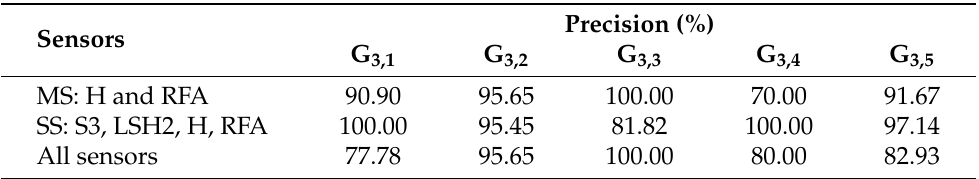
Table 11. Precision achieved for G 3 using